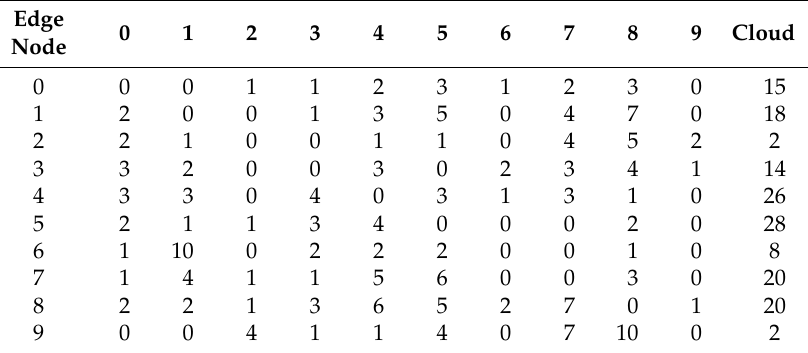
Table 4. The number of migrating services in every edge node and